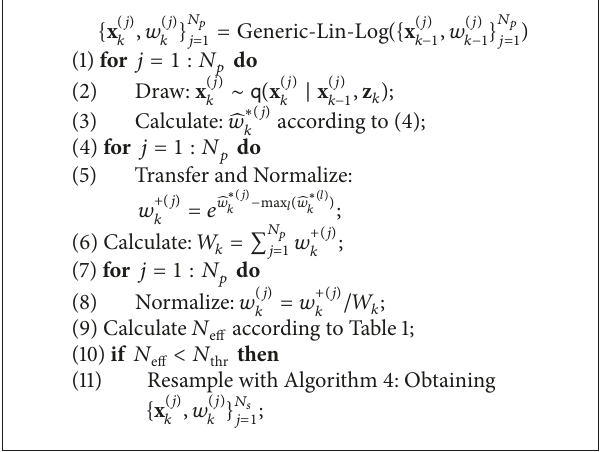
Algorithm 6: Generic-PF in lin-domain with weight calculation in log-domain (Generic